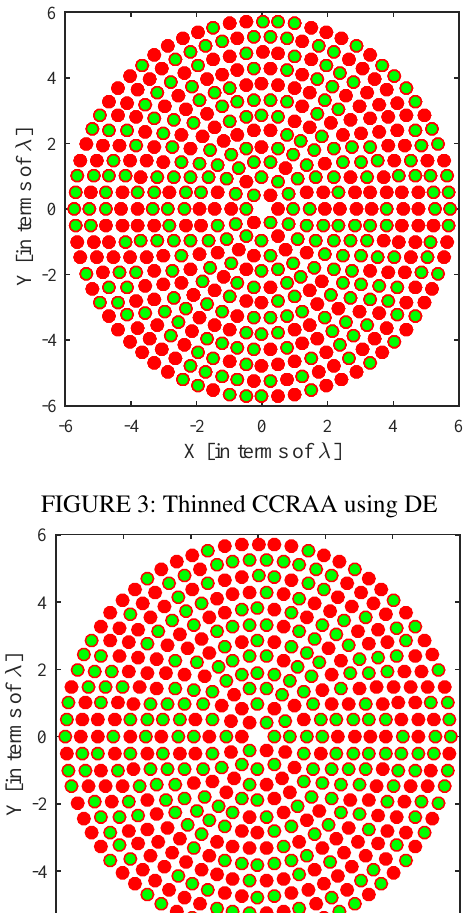
FIGURE 2: Array factor of fully populated Array